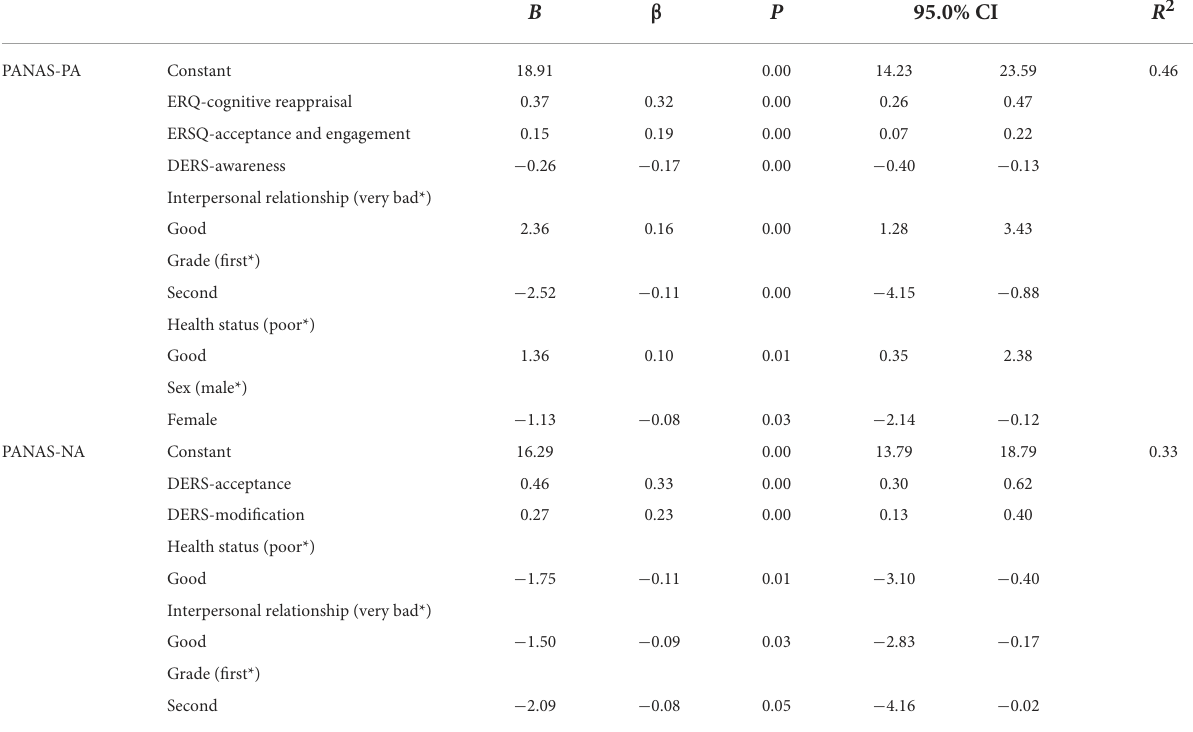
TABLE 3 Multiple linear regression model for PNAS-PA and PNAS-NA ( n =